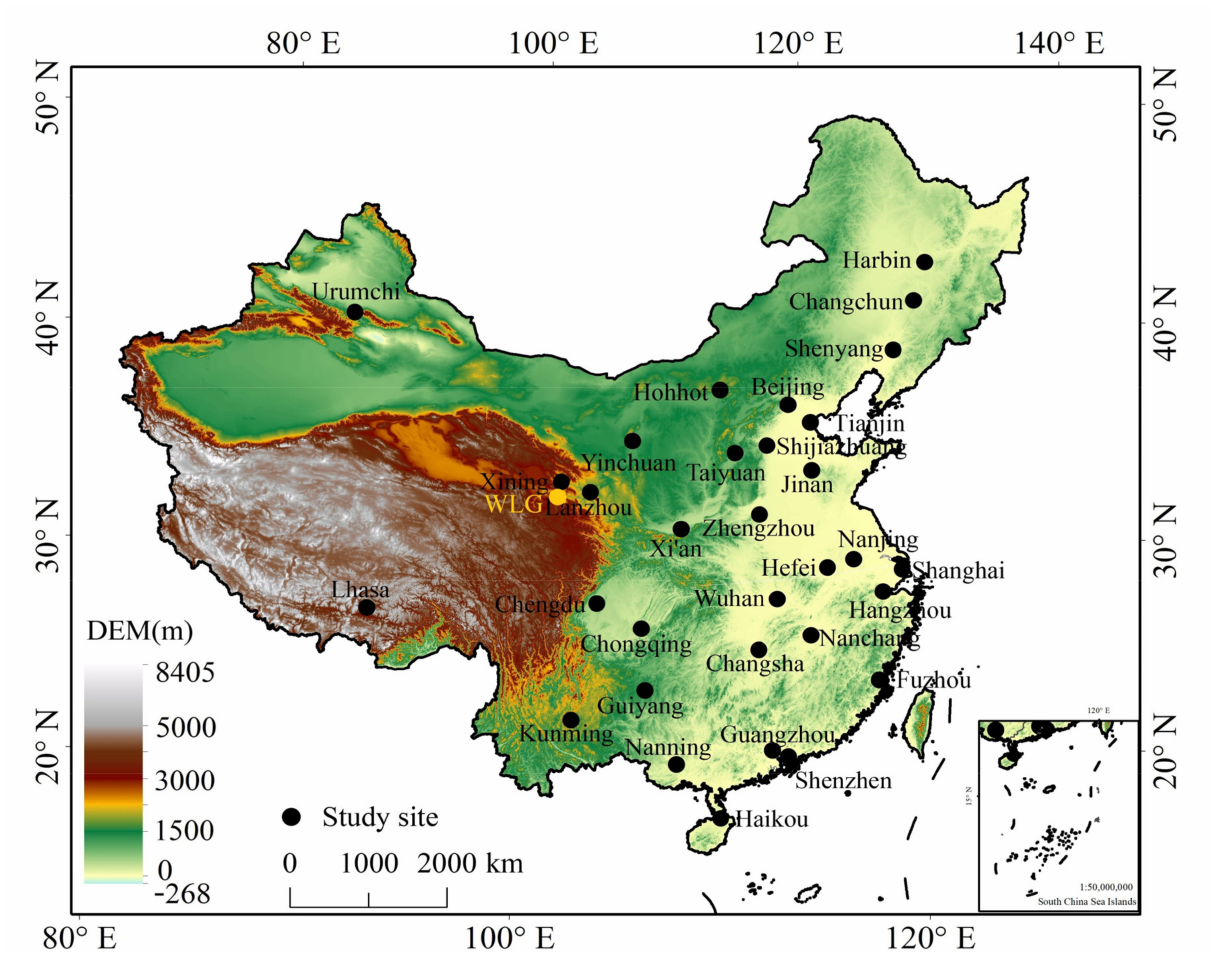
Figure 1. Positions of the 32 major cities in China, with black dots representing the locations of cities and yellow dot representing the locations of Waliguan (WLG)